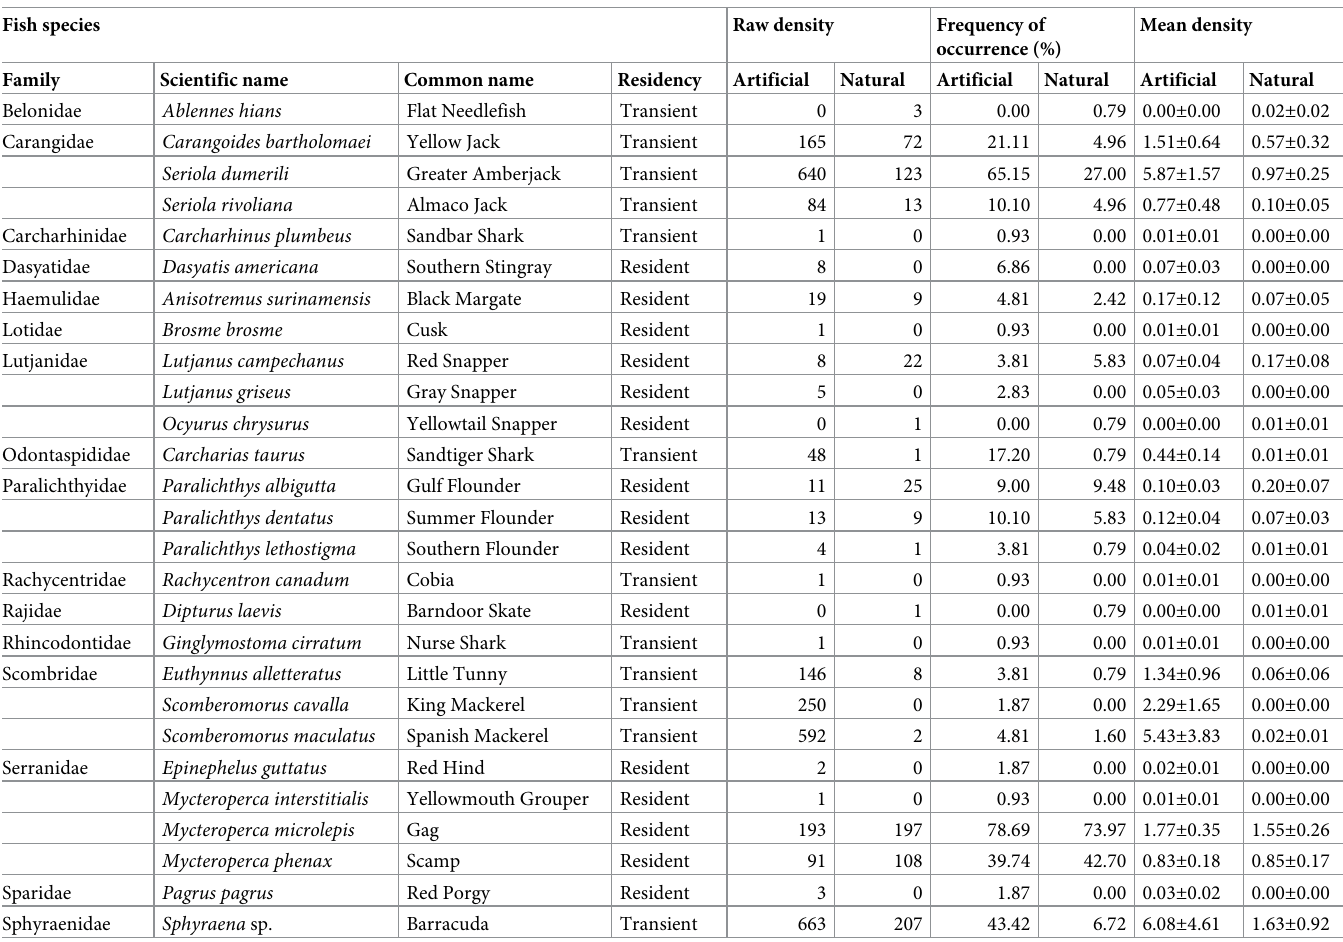
Table 1. Observed density (# per 120 m 2 ) and frequency of occurrence of large reef-associated predators on artificial versus natural reefs per 120 m 2 transect. For each species, raw abundance over 109 transects of artificial reefs and 127 transects on natural reefs is provided, along with the frequency of occurrence (%) that corrects for differing number of transects by reef type. Mean observed density ± SE is provided. Sphyraena sp. represents pooled values of two species, barracuda ( Sphyraena barra- cuda ) and guachanche ( Sphyraena guanchancho